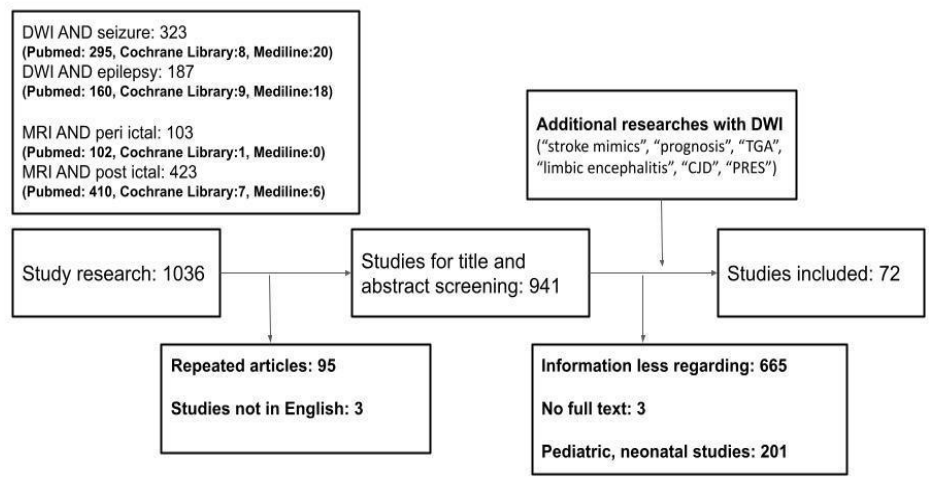
Figure 1. Database search flowchart. DWI, Diffusion-weighted Imaging; CJD, Creutzfeldt–Jakob disease; PRES, Posterior reversible encephalopathy syndrome; ADC, Apparent diffusion coefficient; TGA, transient global amnesia; MRI, magnetic resonance imaging.